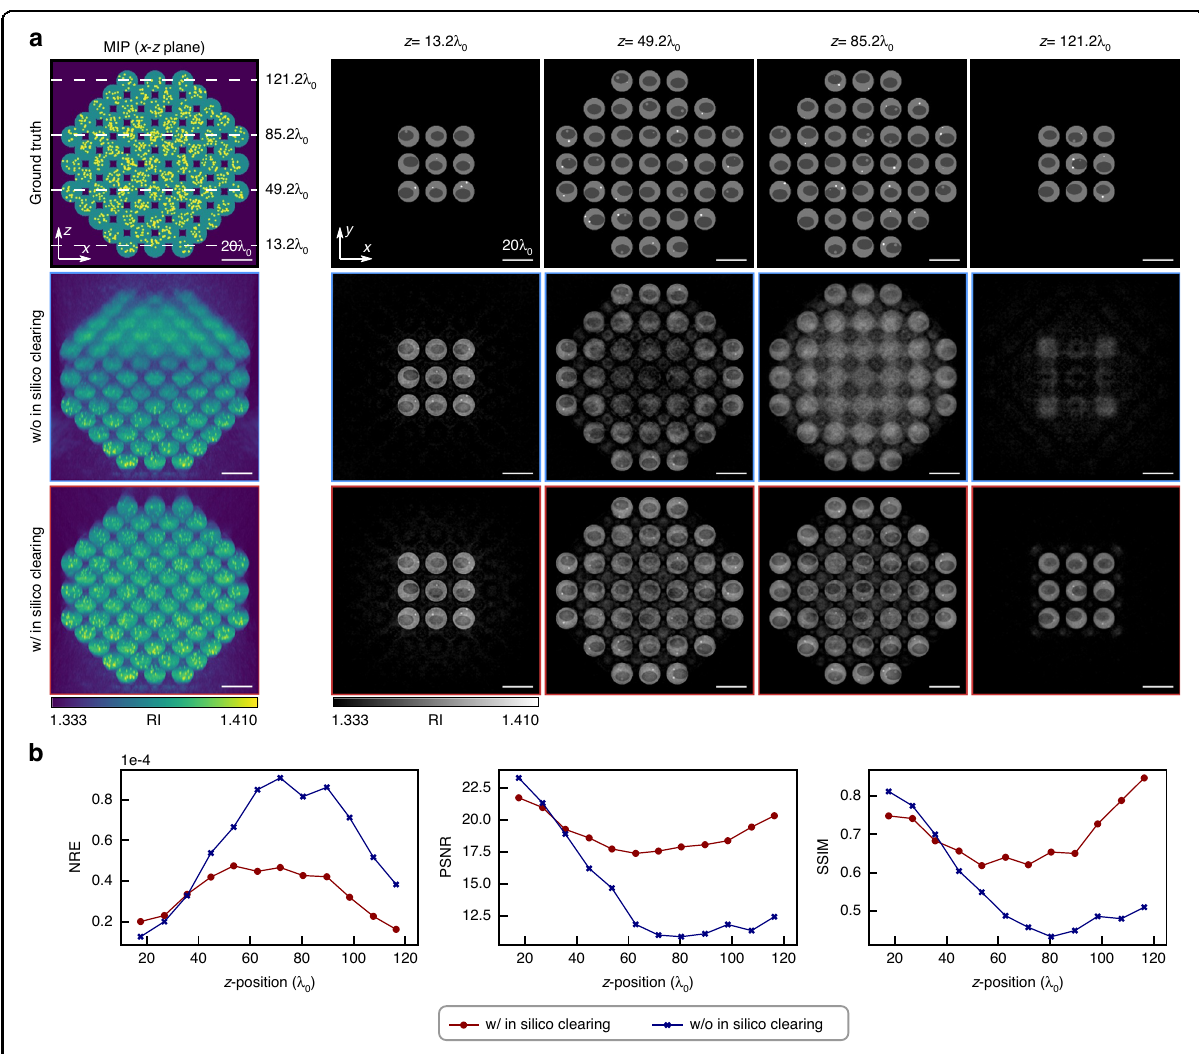
Fig. 2 Numerical evaluation of the performance of in-silico clearing RI tomography using a simulated multicellular spheroid. a Maximum intensity projection (MIP) and cross-sections of RI distributions of ground truth, reconstructed without and with in-silico clearing, respectively. The cross-sections are identi fi ed with a white dashed line in MIP. b NRE, PSNR, and SSIM for without and with in-silico clearing as a function of depth. These metrics are computed in a layer-wise manner, where the layer thickness is set as lattice constant 18 λ